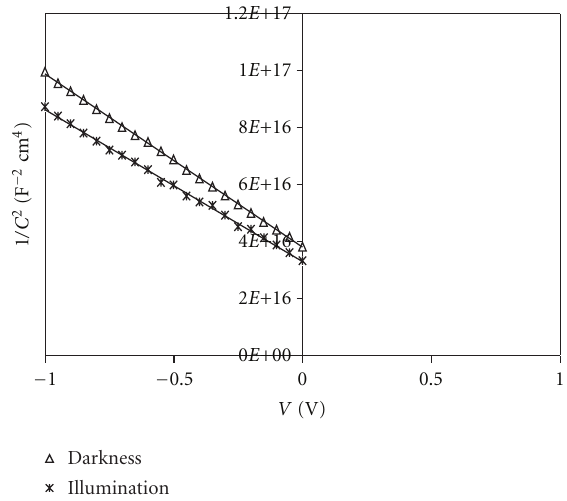
Figure 5: Mott-Schottky plots for Al/PANI-DBSA/n-Si/Ag hetero- junctions under darkness and illumination (0.09W/cm 2 ).